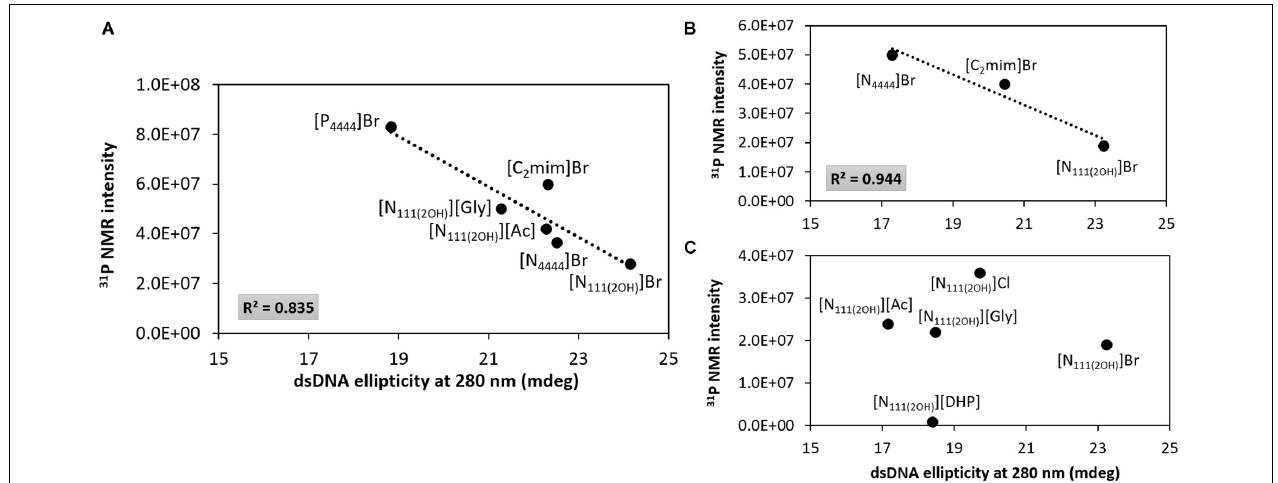
FIGURE 7 | 31 P NMR intensity peak of DNA as a function of dsDNA ellipticity at 280 nm. (A) IL at 5 wt%; (B) bromide-based ILs at 30 wt%; (C) cholinium-based ILs at 30 wt%.